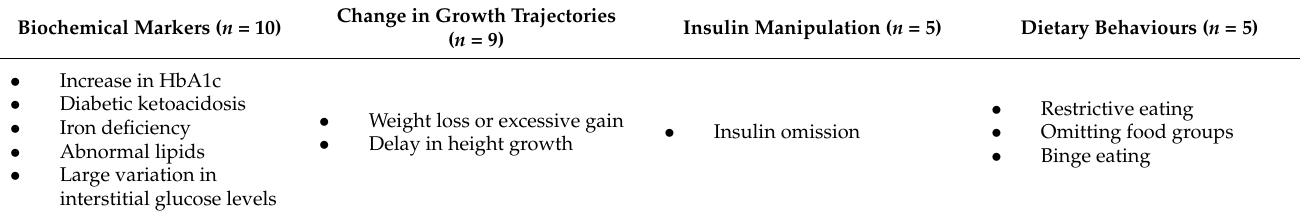
Table 1. Health professional identified clinical indicators to detect the potential for disordered eating. Biochemical Markers ( n =